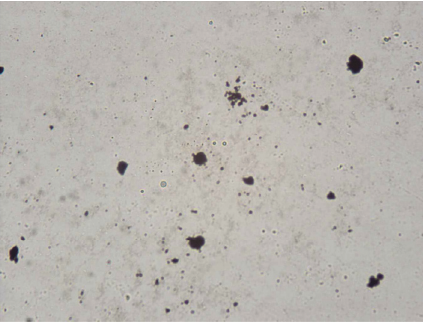
Figure 3: Optical microscope image of CNT dispersion after the treatment with 800 J/mL of US energy, magnified 20 times.